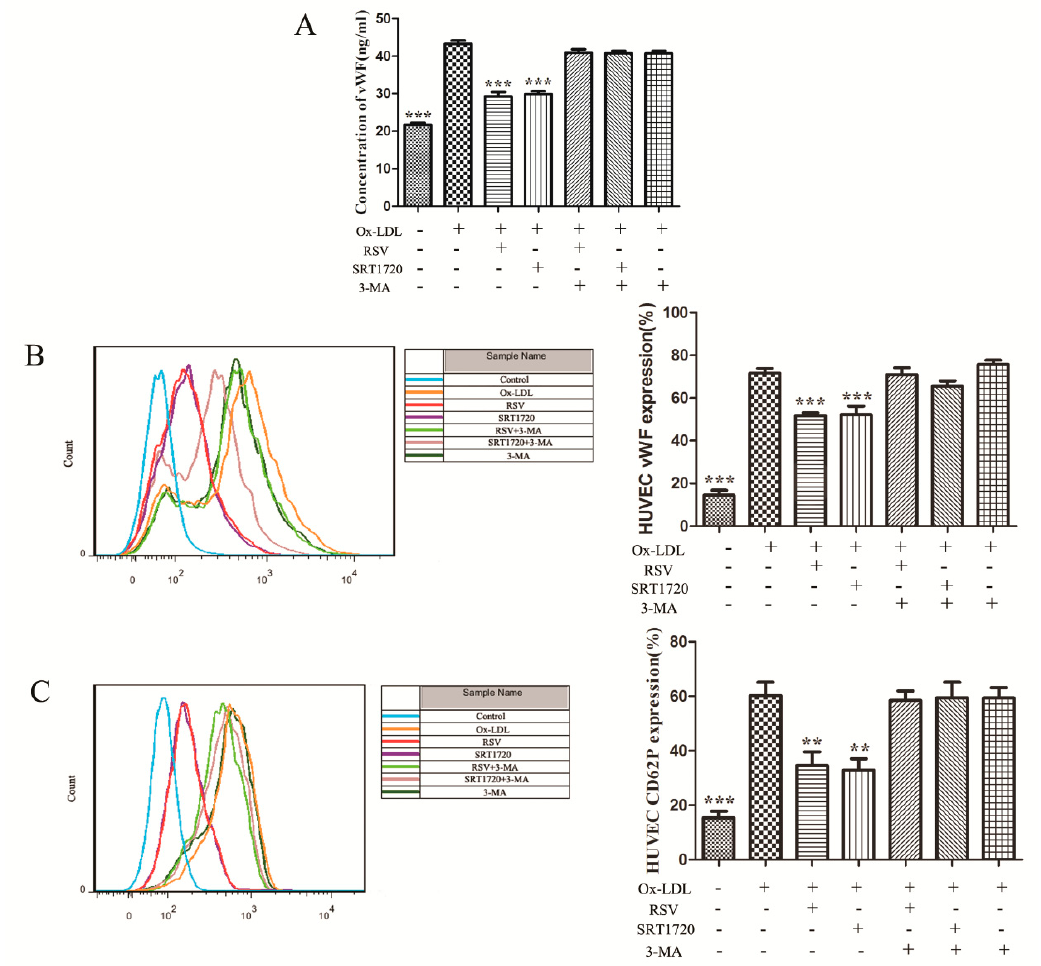
Figure 3. The release of vWF to extracellular ( A ) and the secretion of vWF ( B ) and P-selectin ( C ) to cytomembrane. Values are presented as the means ± SD (ELISA assay: n = 6, flow cytometry: n = 3). Compared with the ox-LDL group, ** p < 0.01, *** p < 0.001.